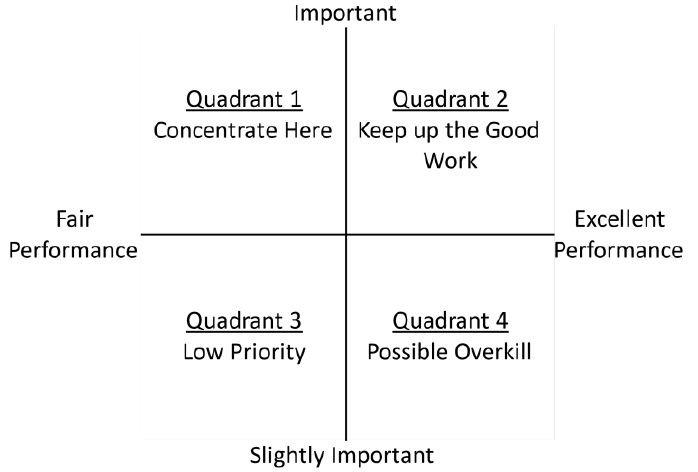
Figure 5: Importance-Performance Analysis (IPA) Grid by Martilla and James (1977, p. 78)